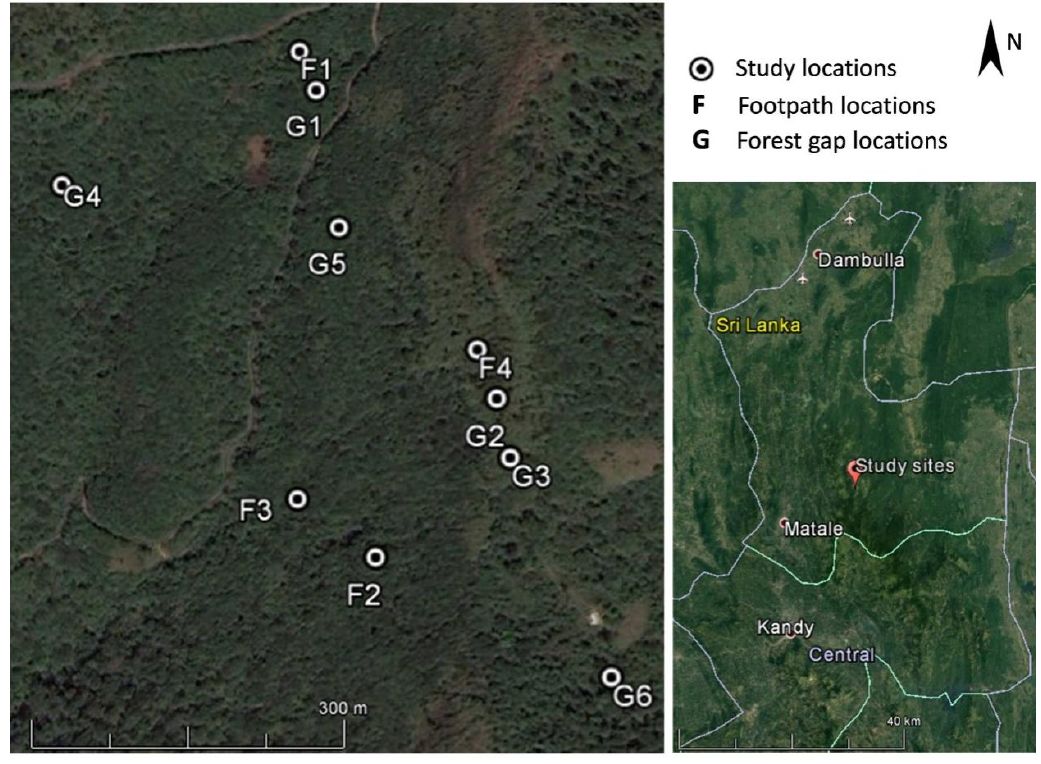
Figure 1: A map showing study sites at Knuckles Forest Reserve, Sri Lanka